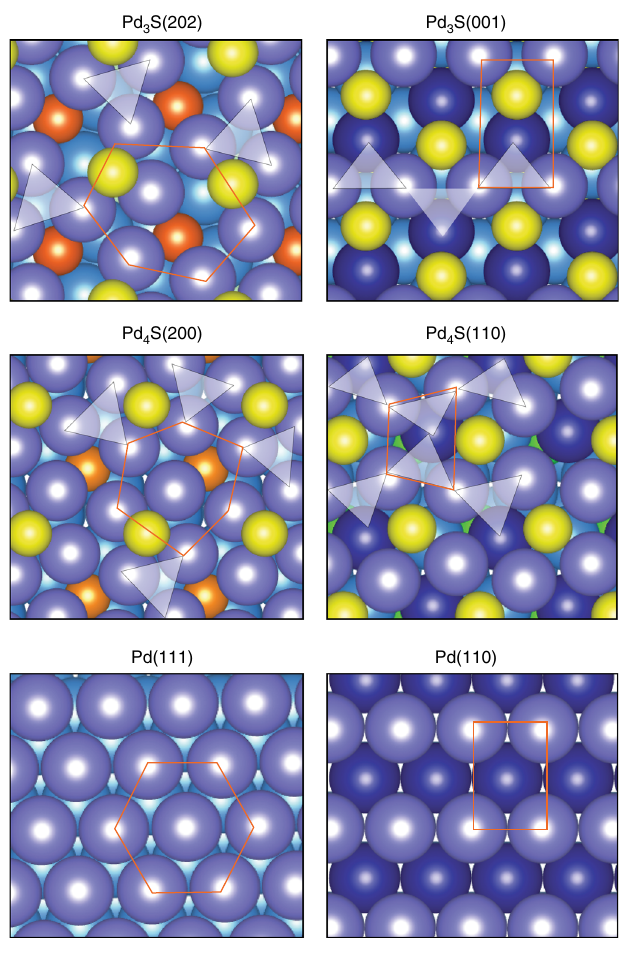
Fig. 3 Structural resemblance of Pd 3 S and Pd 4 S to pristine Pd surfaces. Top views of the low-energy terminations. The structural correspondence of the sul fi de surfaces with the most closely related palladium surface Pd(111) or Pd(110) is highlighted with an orange hexagon or rectangle. The Pd atoms on the Pd 3 S and Pd 4 S surfaces belonging to the ensemble are connected with a white triangle. Inequivalent palladium and sulfur atoms are identi fi ed with different colors (for more details see Supplementary Note 3). Color code: Pd(1) surf (purple), Pd(2) surf (blue), Pd bulk (light blue), S(1) surf (yellow),